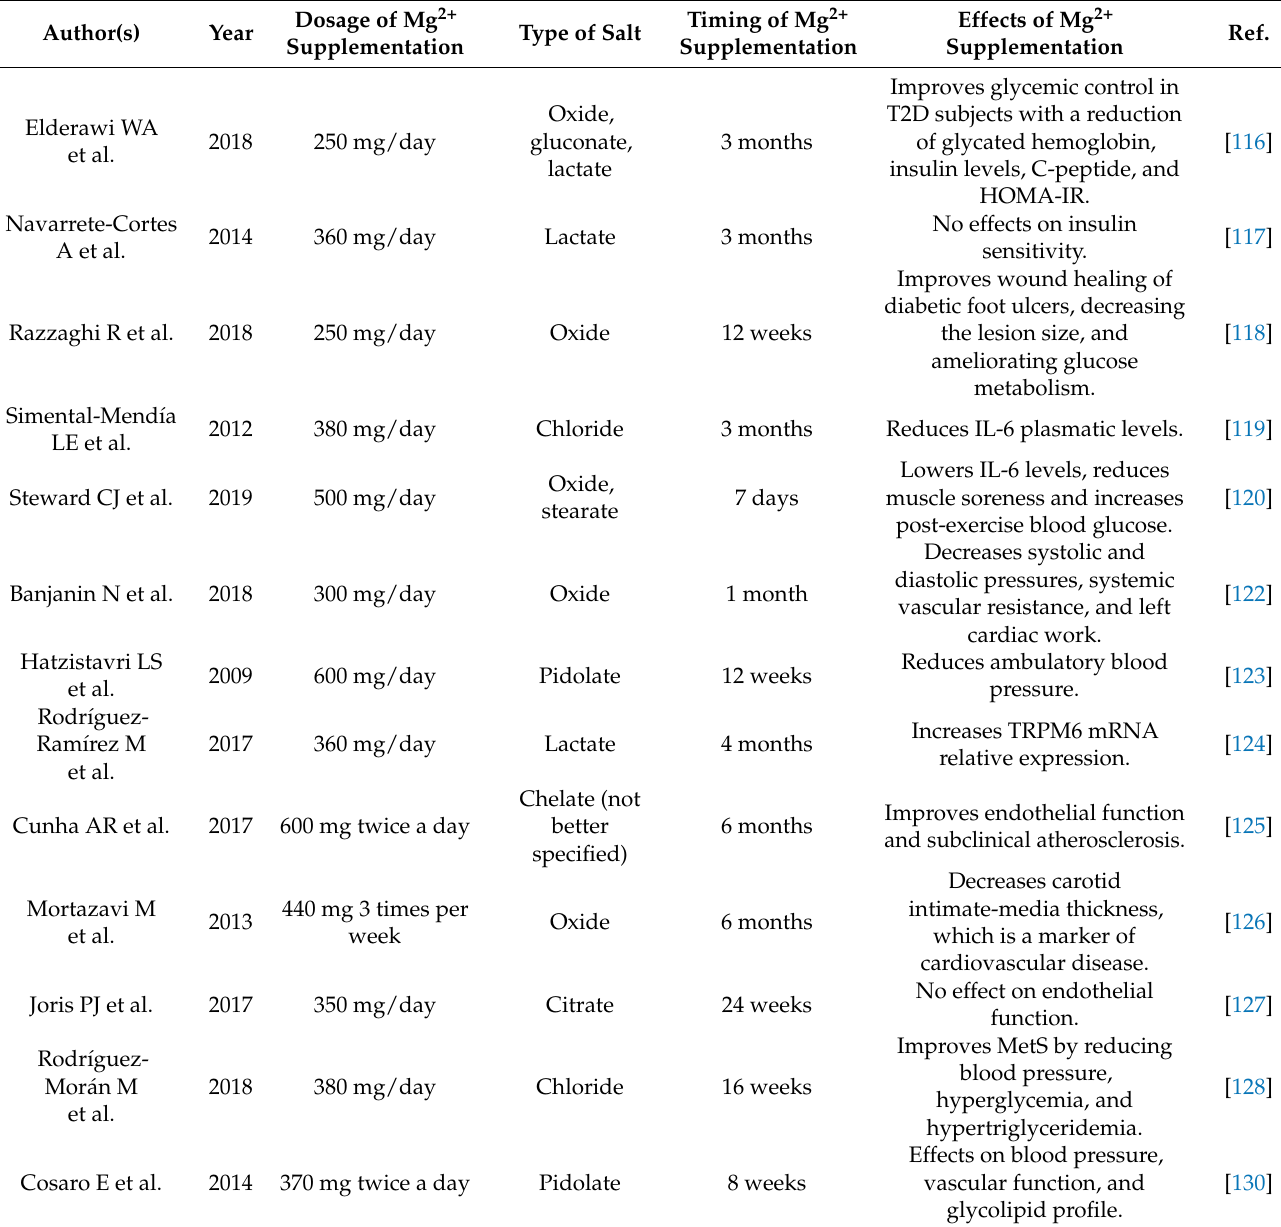
Table 1. A quick recap of the last and most relevant clinical trials describing the effects of Mg 2+ supplementation on obesity, metabolic syndrome (MetS), and type 2 diabetes